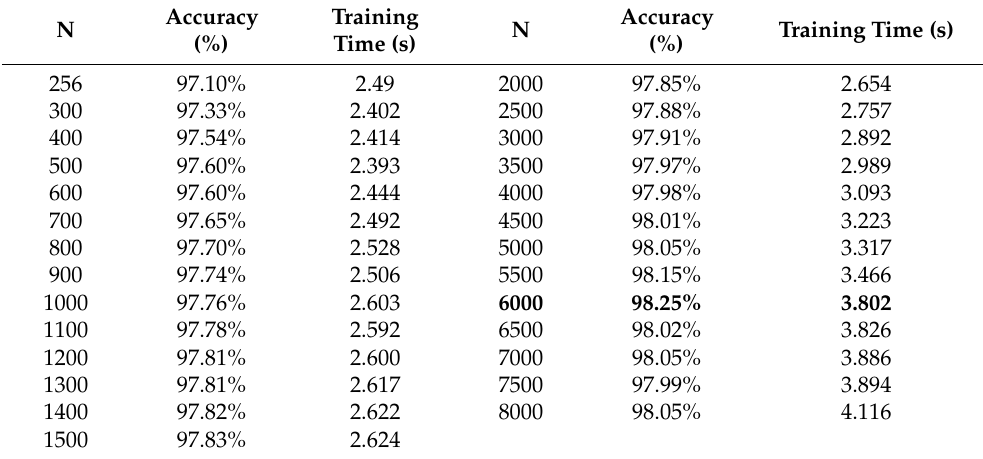
Table 4. The testing accuracies and training times for various numbers of hidden layers with γ set at 5 × 10 − 4